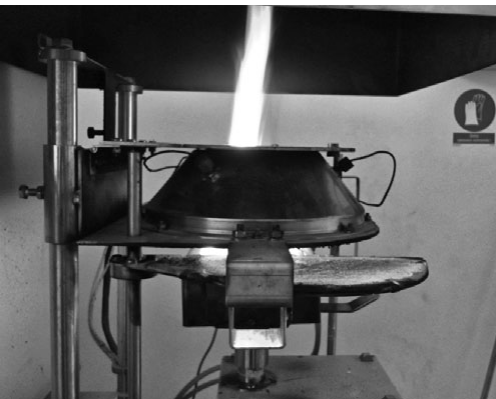
Fig. 3. Pine timber specimen during the